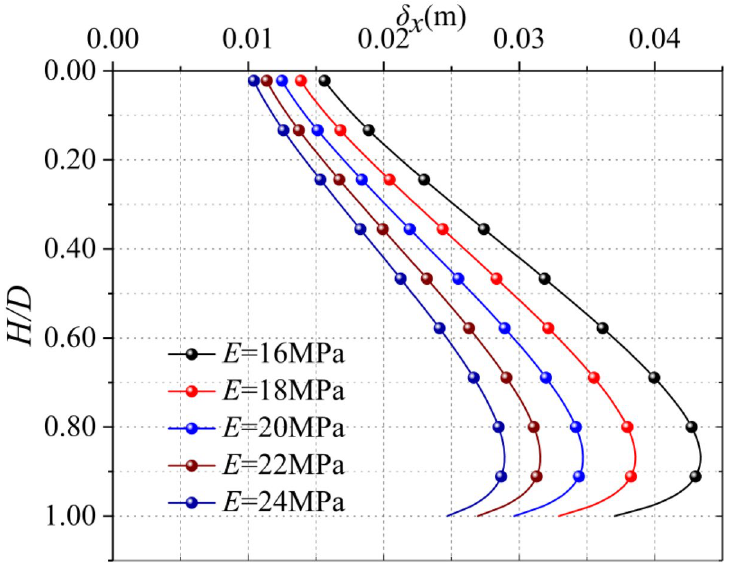
Figure 5. Horizontal displacement with different elastic